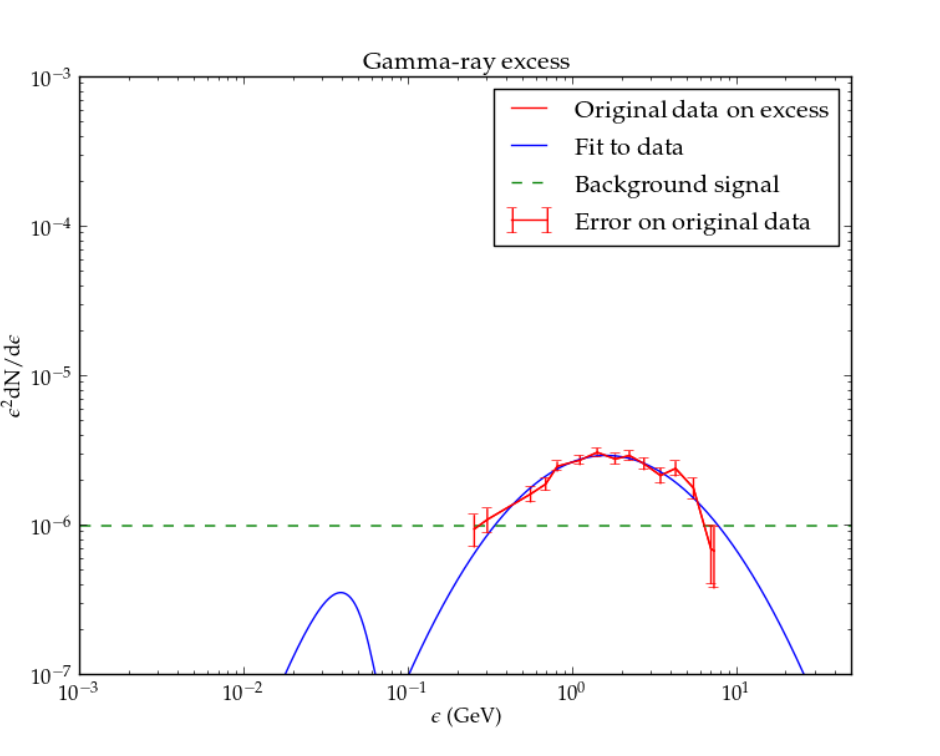
Figure 10. Fit to the Fermi excess with bouncing black holes. Reprinted from